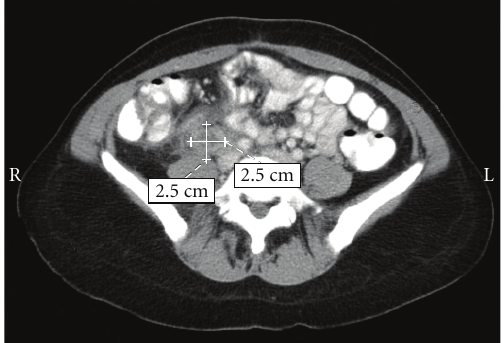
Figure 1: Longitudinal section right and left ovarian veins case 2.